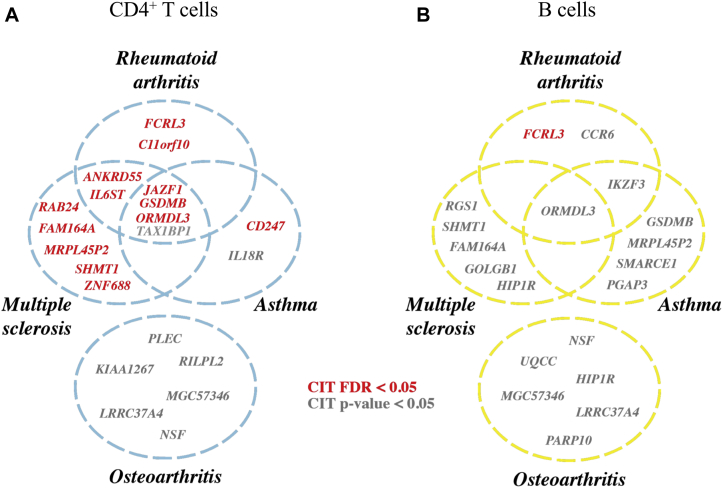
MeQTL-mediated transcriptomic regulation highlights shared etiology at common IMD loci. Venn diagrams showing the overlap of genes targeted by RA, MS, asthma, and OA risk loci for whom the genetic effect on expression in CD4+ T cells (A) and B cells (B) is mediated by DNAm according to CIT.